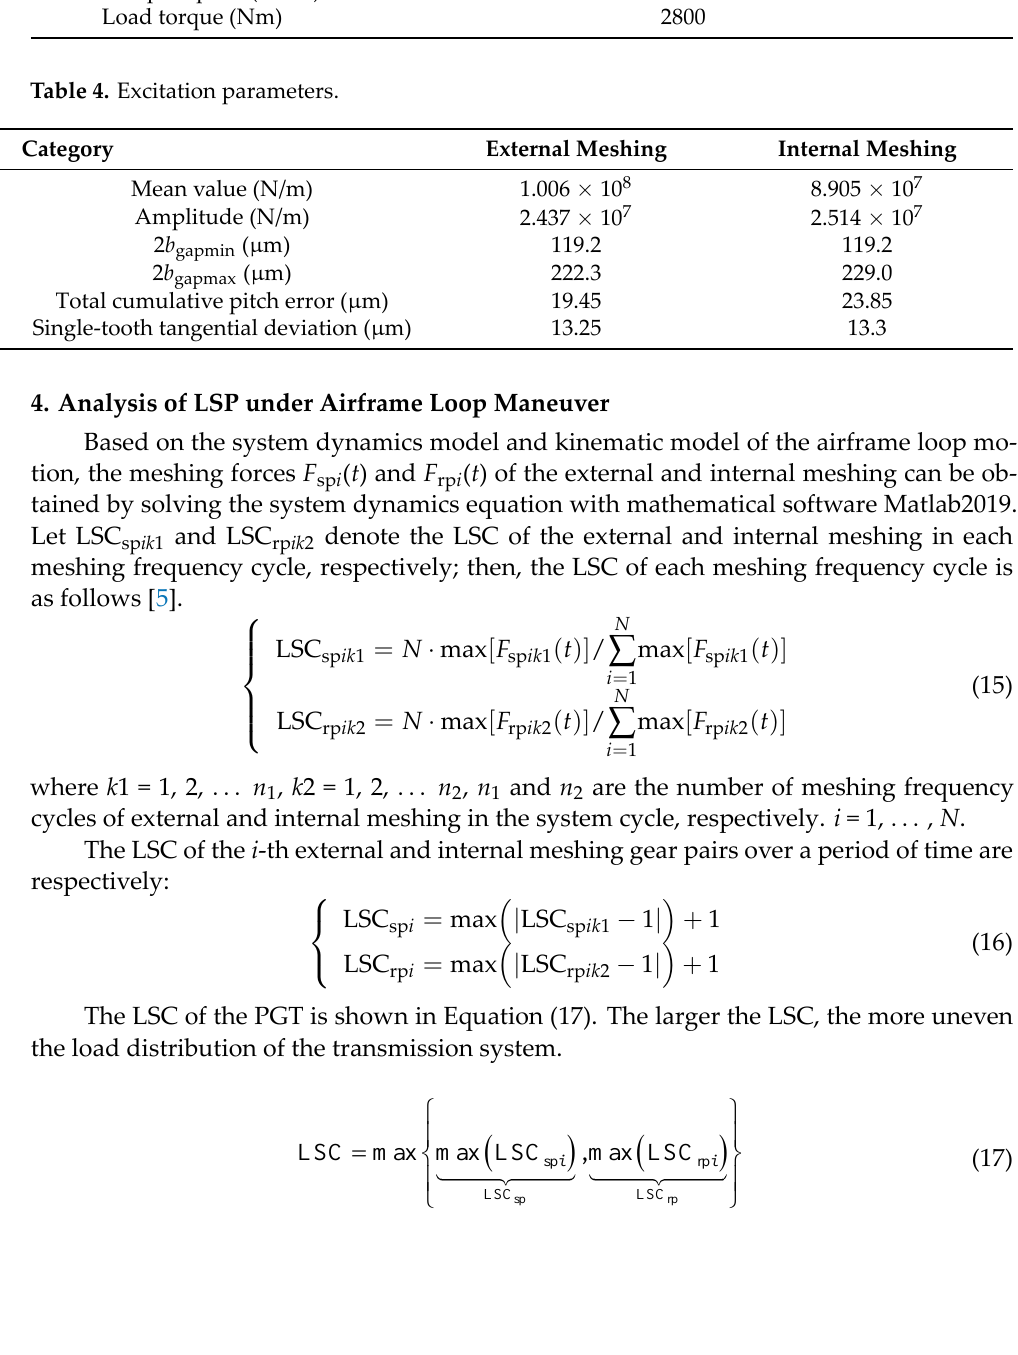
Table 4. Excitation